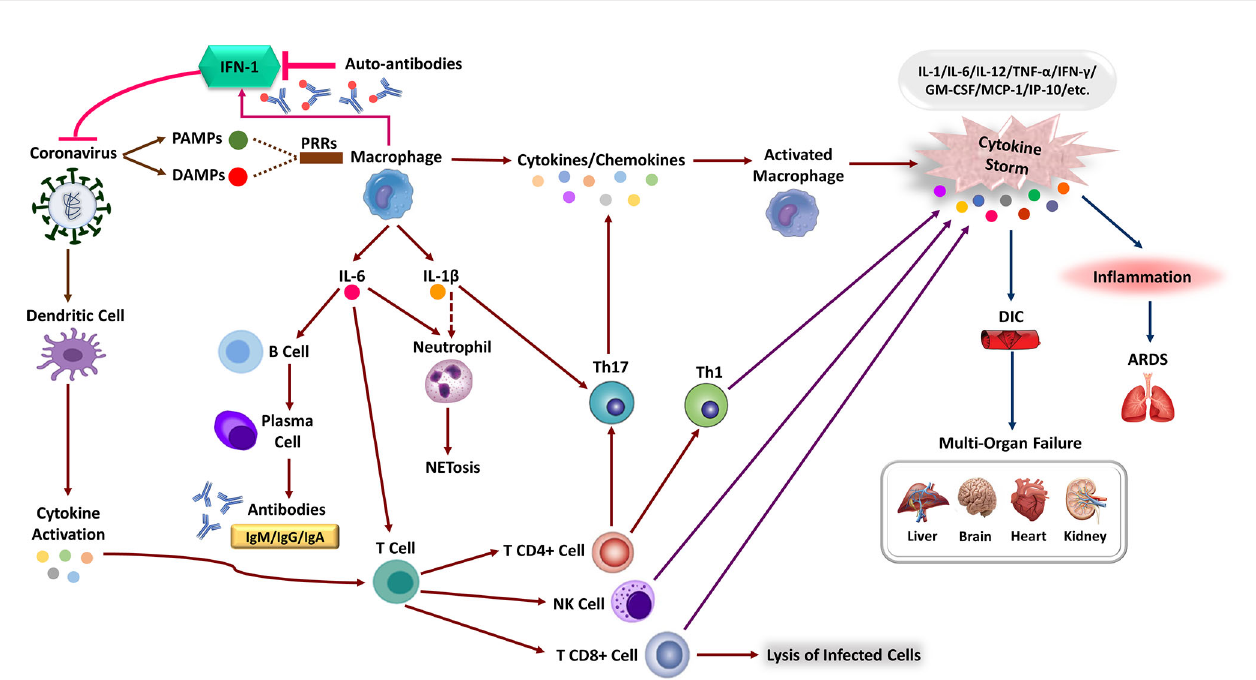
FIGURE 2 | The immune response corporation in covid-19 disease. Type 1 interferon (IFN-I) immune response plays a pivotal role in effective immunity against SARS- CoV-2 infection and rapid viral clearance. Following SARS-CoV-2 infection, the IFN-1 initiates via recognizing PAMPs/DAMPs by PRRs of the human immune cells and releasing in fl ammatory cytokines (e.g., IL-1 beta, IL-6). The expression of numerous in fl ammatory cytokines leads to activation of neutrophils (NET formation) and attraction of different immune cells toward the site of infection. Macrophages activation, Dendritic Cell (DC) maturation and in fl ammatory cytokines stimulate the adaptive immune response to join the fi ght against SARS-CoV-2. Activation of T-cells via cytokines promotes multiple T-cell differentiation (i.e., CD4 +, CD8 +, NK cell, Th1) that directly kills virus-infected cells. Activated B-cells produce virus-speci fi c antibodies that would participate in a successive immune response. In patients with severe forms of COVID-19, the delayed IFN-I pathways or neutralizing auto-Abs will lead to immune system overreaction and the generation of high in fl ammatory cytokine levels. The aberrant induction of the immune system and the production of various pro-in fl ammatory cytokines (e.g., IL-1, IL-6, MCP-1, TNF- a , and etc.), the so-called “ cytokine storm, ” leads to severe COVID-19 immunopathology. These can cause severe local damage to the lungs (e.g., ARDS) and other organs (e.g., DIC), and in the worst case, can lead to Multi-Organ Failures (MOF) and even